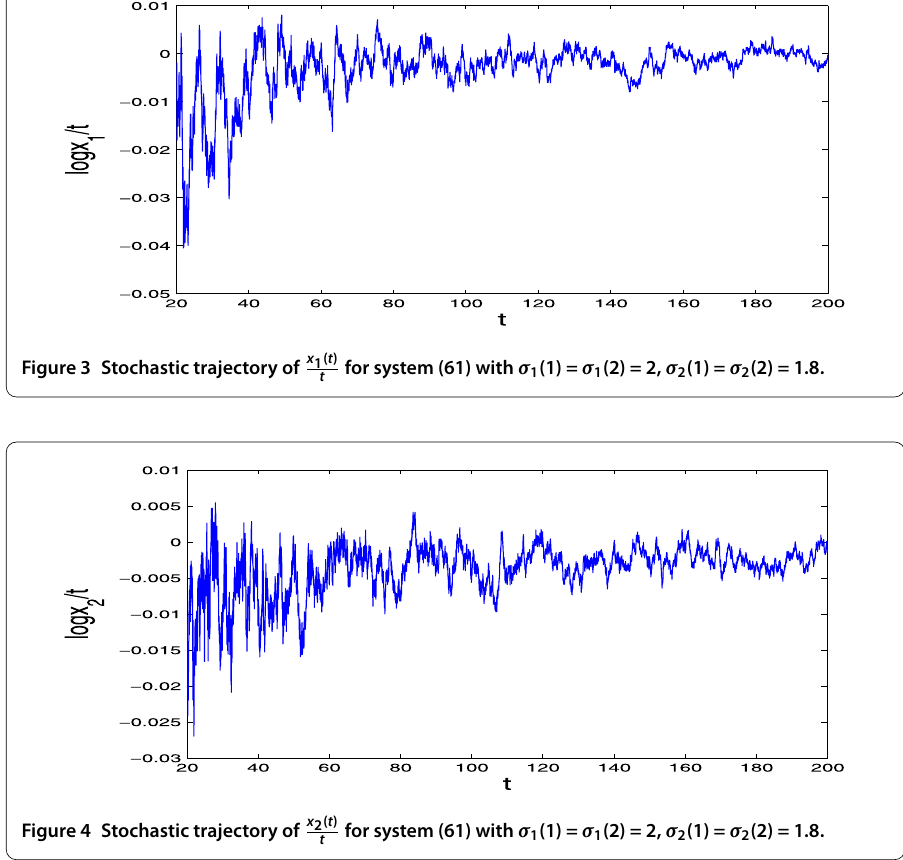
Figure 4 Stochastic trajectory of x 2( t )